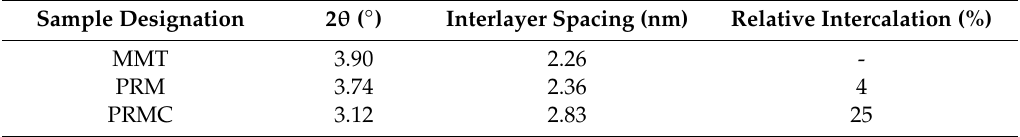
Table 2. Interlayer spacing of MMT and its relative intercalation in nanocomposites.